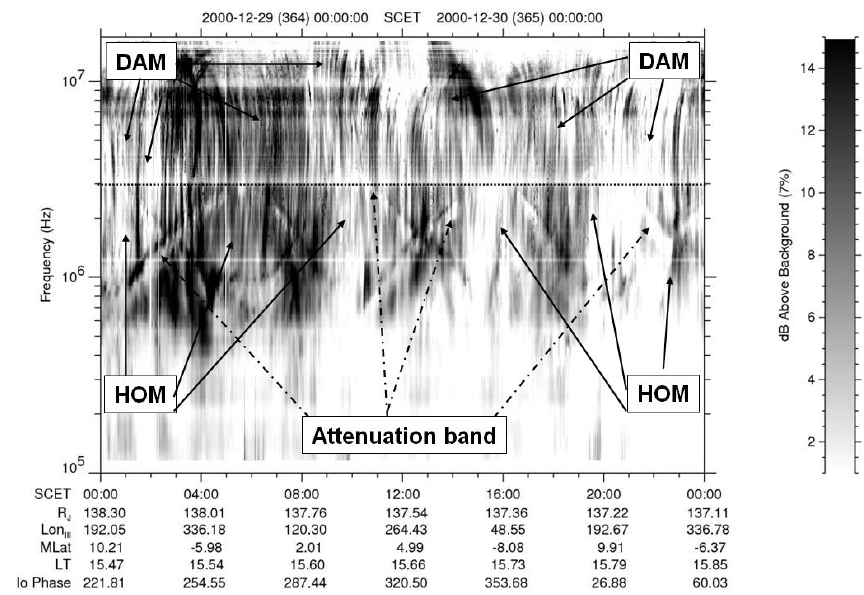
Figure 2. Dynamic spectrum recorded by the Cassini RPWS experiment on 29 December 2000. The Jovian DAM and HOM emissions principally occur in the frequency ranges of 16–8MHz and 3000–100kHz, respectively. The horizontal dashed line (at 3MHz) indicates the common way to recognize the upper frequency of Jovian HOM emissions. The attenuation band appears as incomplete sinusoid traces occurring when the northern and southern magnetic field axes are toward the observer (i.e., Cassini spacecraft). Both traces cross each other in the equatorial plane of the planet (e.g., 03:30, 08:00, 12:45, 18:00 and 23:30UT).